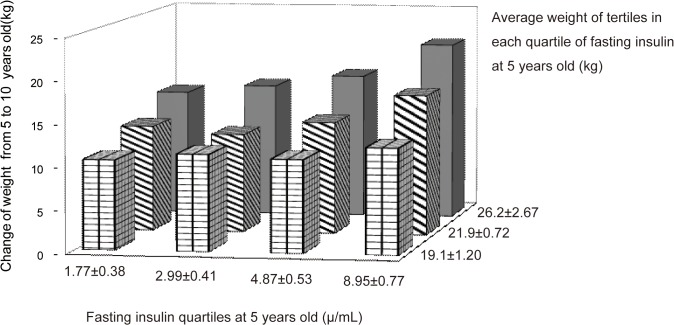
The change of weight during a 5-year follow-up related to the plasma fasting insulin and weight at baseline.With the increase of fasting insulin and weight at baseline, weight increased gradually and became greater. The mean value weight gain during the 5-year follow-up in the top weight at baseline tertile was significant greater than that in the lowest tertile in each fasting insulin at baseline quartile (p<0.01).The greatest weight gain was in the top quartile of fasting insulin and meanwhile in the top tertile of weight at baseline. Baseline fasting insulin significantly correlated with ΔWeight in the subgroup of top and middle weight tertile (r = 0.39, P<0.0001 and r = 0.33, P<0.0001, respectively), but not in the lowest weight tertile subgroups at baseline (r = 14, P>0.05).